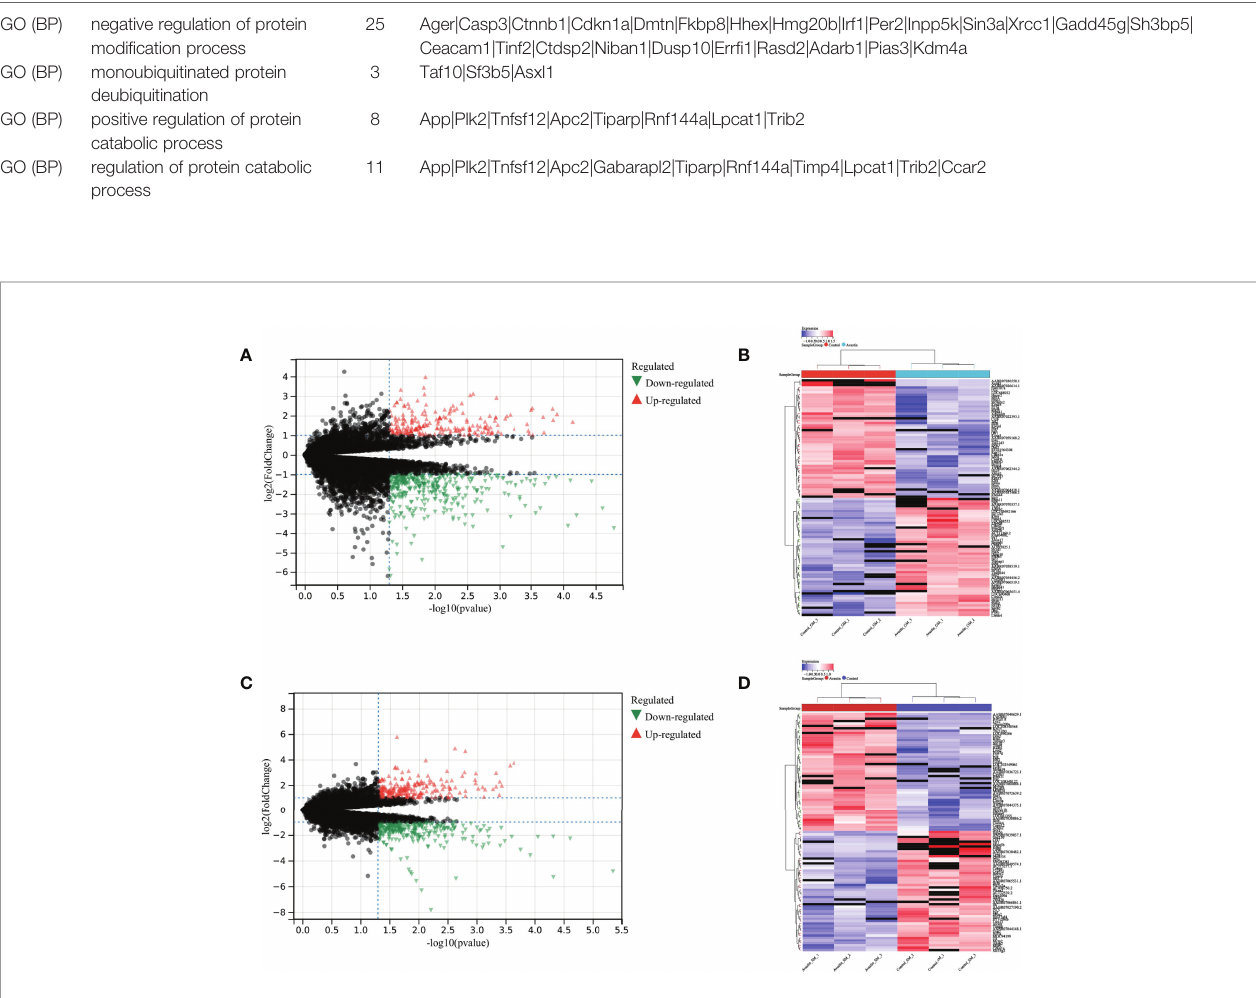
FIGURE 4 | Differential expression analysis results. Differential expression analysis of genes in gastrocnemius muscle, with (A) volcano plot showing the differential expression results of genes, (B) heat map showing the distribution of up- and down-regulated genes; Differential expression analysis of genes in soleus muscle, with (C) volcano plot showing the differential expression results of genes, and (D) the heat map showing the distribution of up- and down-regulated